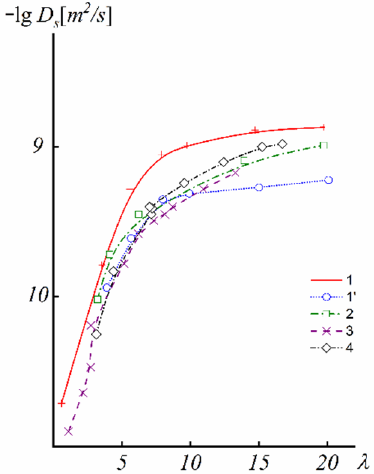
Figure 21. Water self-diffusion coefficient humidity dependences: (1,1’) H + ionic form of the mem- brane MC-44; (2) Na + ionic form of the MC-40 membrane; (3) H + ionic form of the MC-40 membrane; (4) Na + ionic form of the macropore sulfo cation exchanger CU-23. Adapted from [33].